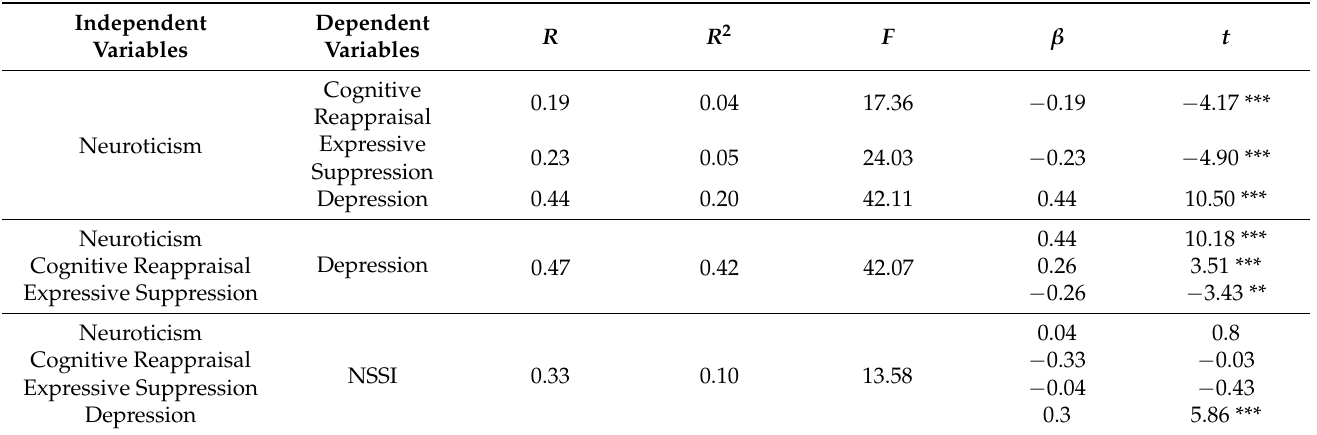
Table 2. Multivariate regression analysis of neuroticism, emotion regulation (ER), depression, and NSSI.